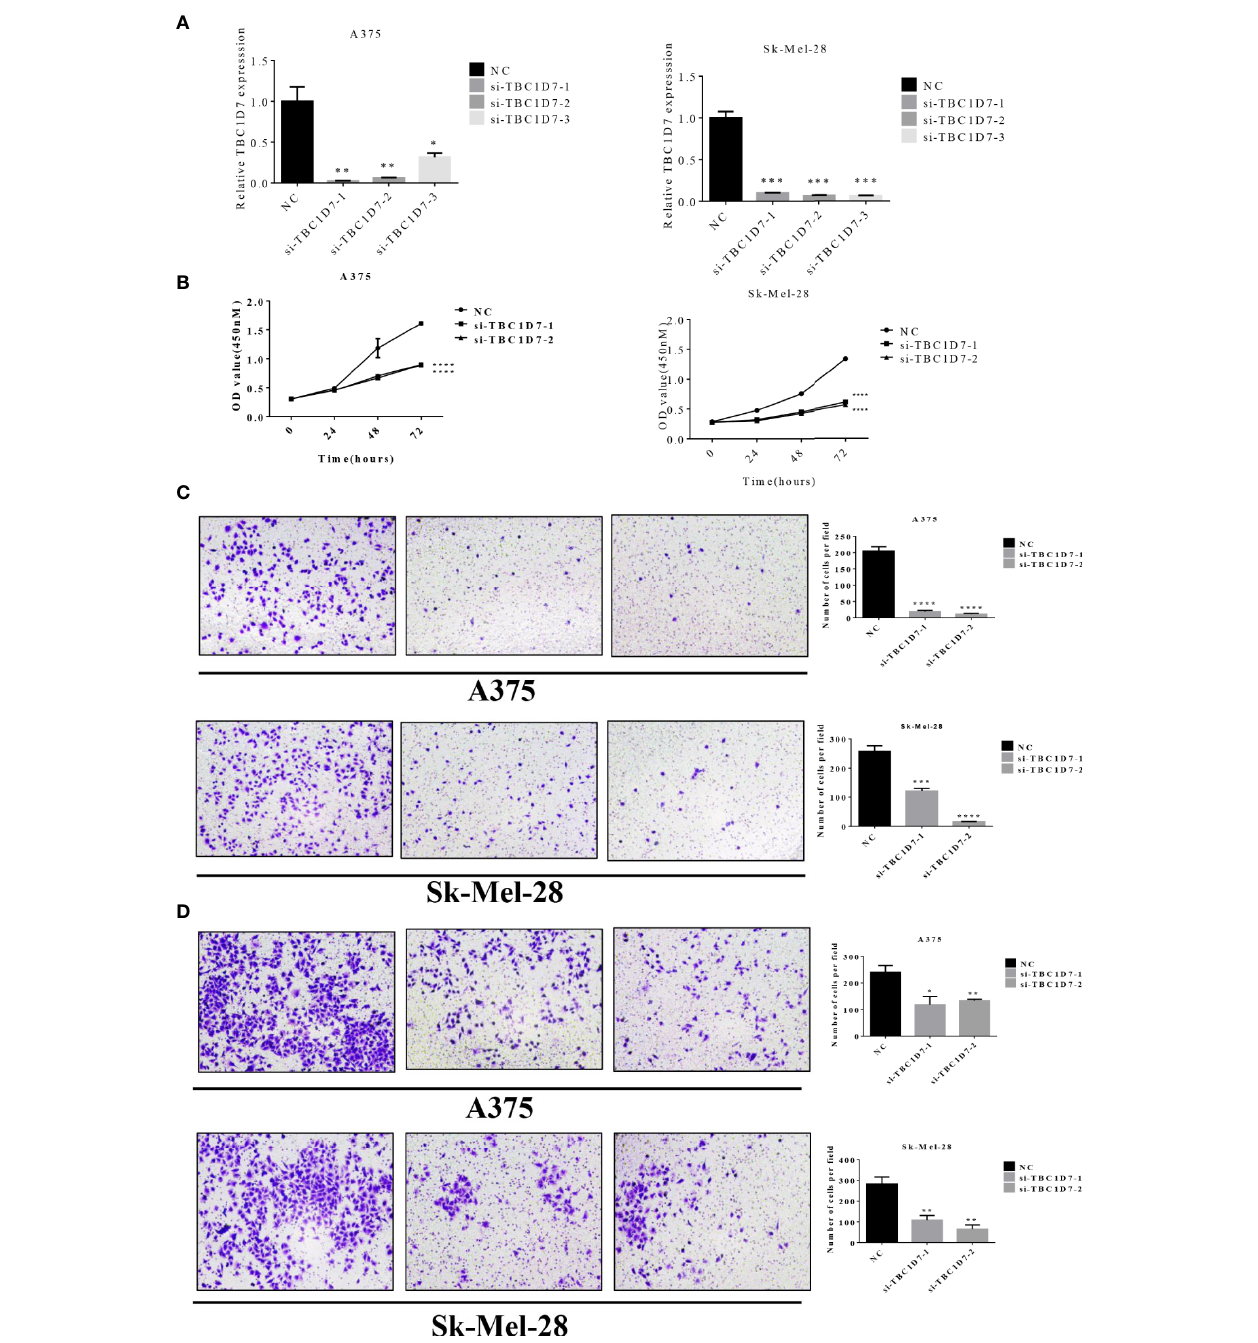
FIGURE 10 | Interference of TBC1D7 expression inhibits melanoma cell migration and invasion. (A) The relative mRNA levels of TBC1D7 at 36 h after transfection with si-TBC1D7-1, si-TBC1D7-2, si-TBC1D7-3 and NC as control in melanoma cells A375 and Sk-Mel-28 were measured by RT-PCR. GAPDH was used as a control. *p <, **p < 0.01, ***p < 0.001. (B) Melanoma cells A375 and Sk-Mel-28 interfered with si-TBC1D7, 2.0 x 103 cells planted into 96-well cultured for 24, 48, 72 h, CCK-8 kits were used to detect the proliferation at OD450nM following the manufacturer ’ s instruction. Each group have 5 replicates(n=5) with 3 independent experiments. ****p < 0.0001. (C) A number of 1 x 10 4 cells were seeded into the upper chambers with 550ul medium containing 30% FBS put into the lower chambers. Chambers after cultured for 24 h were fi xed with 4% paraformaldehyde, stained with crystal violet and imaged by microscope. Representative images of migration of A375 and Sk-Mel-28, the numbers of magration cells per fi eld were calculated, and the results are presented as the mean ± SD (n = 3). ***p < 0.001, ****p < 0.0001. (D) 5 x 10 4 cells were seeded in the chambers embed with matrigel cultured for 30 h and performed as material and methods. Representative images of invasion of A375 and Sk-Mel-28, the numbers of invasion cells per fi eld were also calculated. *p < 0.05, **p <